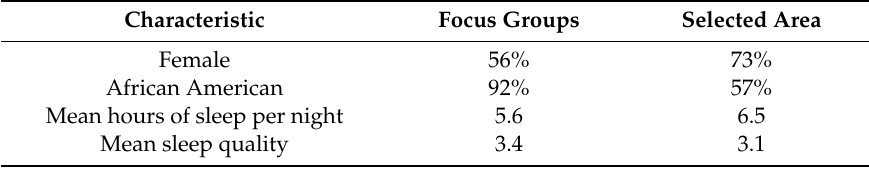
Table 1. Descriptions of focus group participants compared to the selected